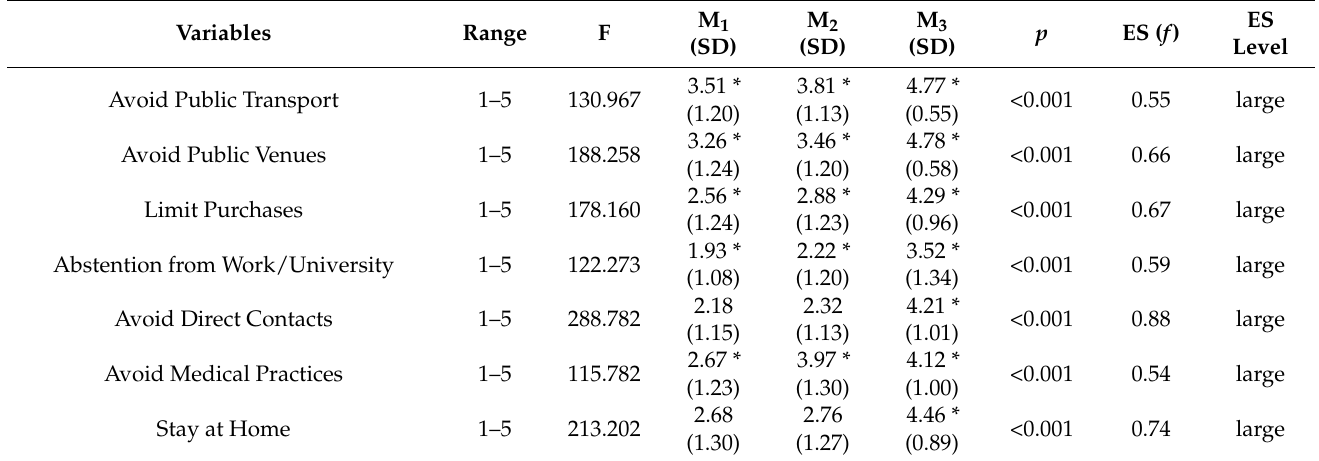
Table 9. Variation of self-restraint intentions in the three